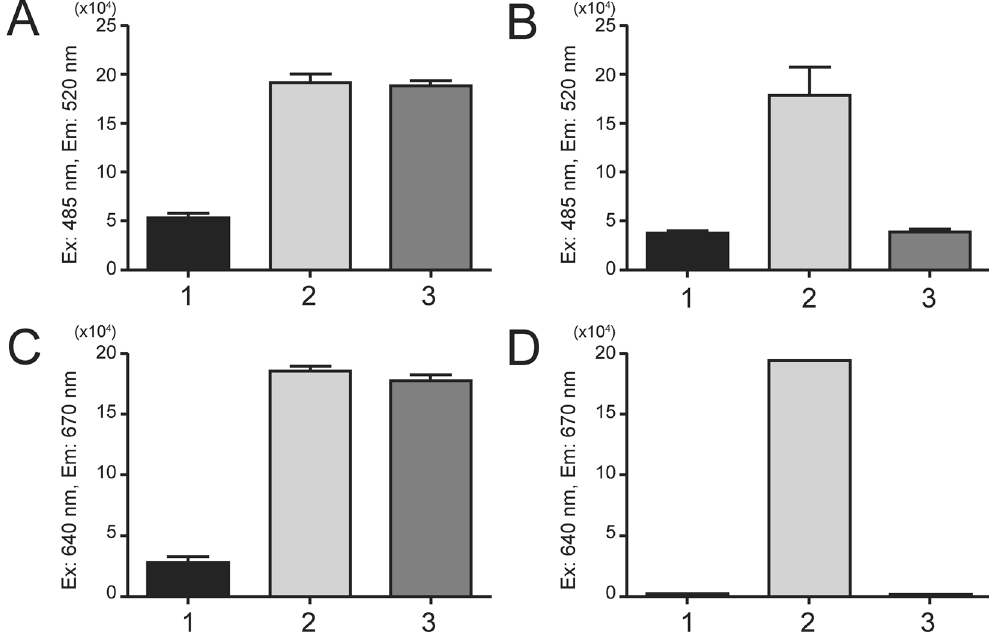
Figure 4. Streptavidin and His-tag pull down assay of CFPS malE-en2NTS 1 and E. coli expressed en2NTS 1 . Binding assay, testing capability of binding to Biotin-NT using Streptavidin dynabeads in combination with ( A ). CFPS produced malE-en2NTS 1 and ( B ). The E. coli expressed en2NTS 1 control. Each graph reads 1. Receptor alone. 2. Biotin-NT plus receptor. 3. Biotin NT, receptor and unlabelled NT 8–13 competitor. Binding assay using His-tag isolation dynabeads in combination with ( C ). CFPS produced malE-en2NTS 1 ( D ). E. coli expressed en2NTS 1 . Each graph reads 1. Receptor alone. 2. A647-NT 8–13 plus receptor. 3. A647-NT 8–13 , receptor and NT 8– ± 13 competitor. Data is presented as triplicate experiments